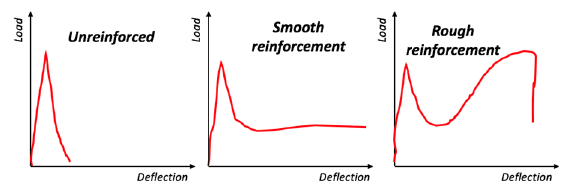
Figure 2. Schematics of load deflection curves of mortar bars reinforced with 3D printed polymeric bars subjected to 3 ‐ point bending (after [18]).